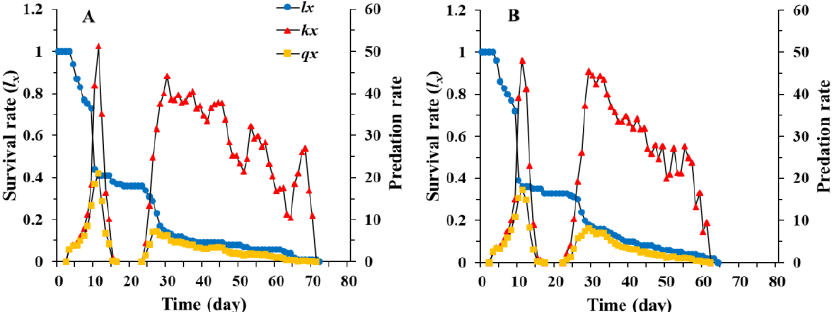
Figure 4. Age-specific survival rate ( l x ), age-specific predation rate ( k x ), and age-specific net predation rate ( q x ) of Chrysopa pallens ever cultured on Megoura japonica ( A ) and Corcyra cephalonica eggs ( B ) under fluctuating temperature conditions in a greenhouse.